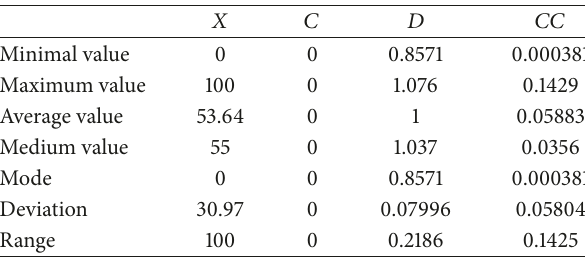
Table 11: The statistical analyses of strategies 𝐶 , 𝐷 , and 𝐶𝐶 .